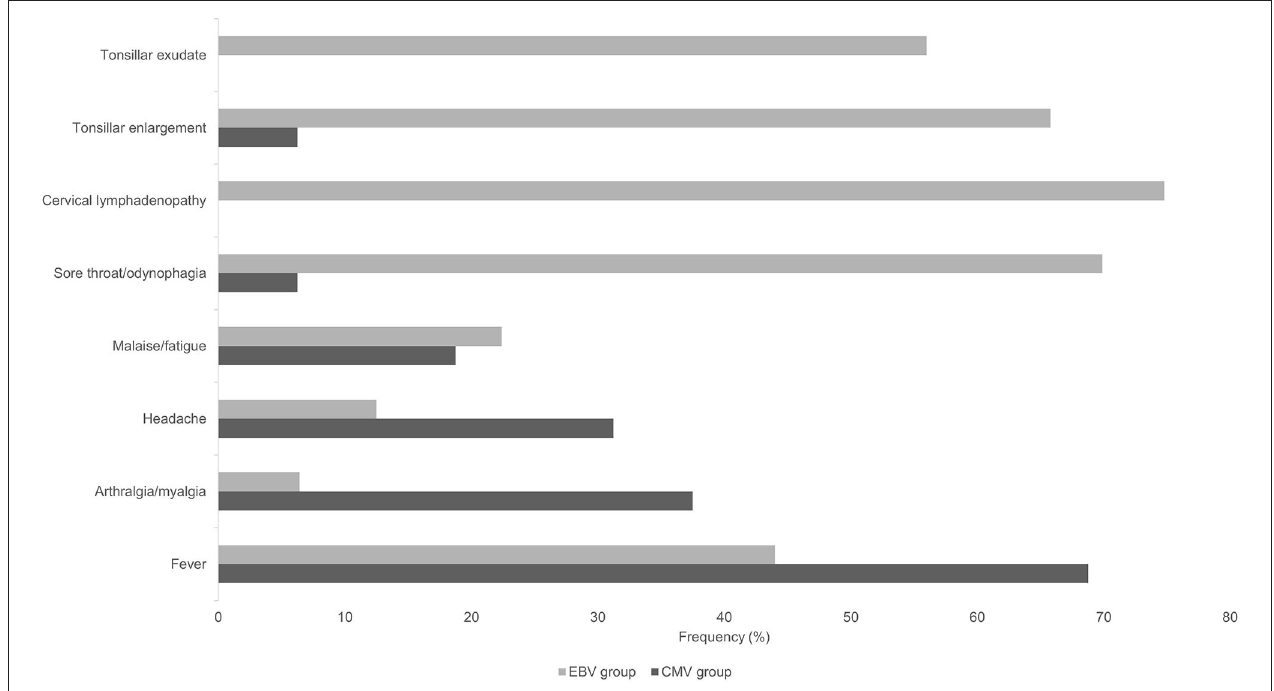
FIGURE 2 | Frequency of symptoms and findings of clinical examination in patients with primary CMV and primary EBV infection.